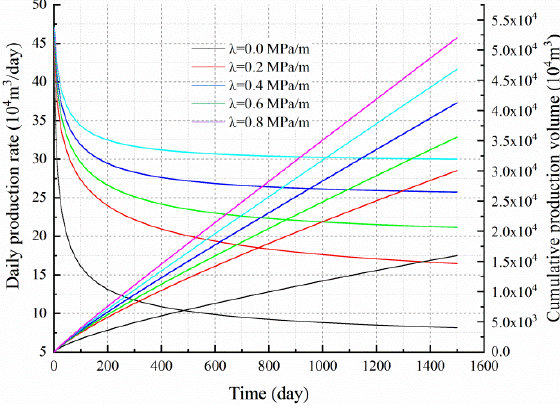
Figure 9. The e ff ect of di ff erent slippage factors on Figure 9. The effect of different slippage factors on productivity.